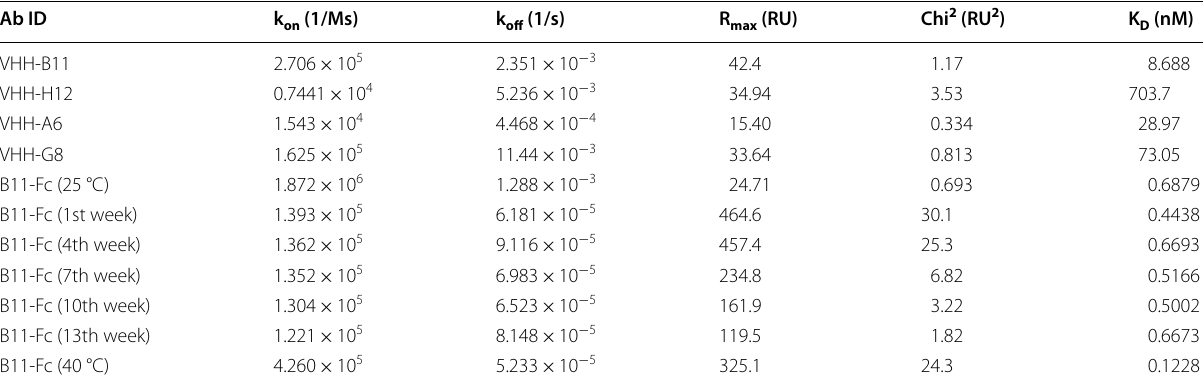
Ab ID represents the name of each antibody. k on (1/Ms) and k off (1/s) values, respectively represent the binding and dissociation levels of the VHH interacted with the hPCSK9. K D (M) was the measured affinity value acquired by the k off value divided by the k on value. R max (RU) represents the maximum binding response unit. Chi 2 (RU 2 ) represents the curve-fitting accuracy, generally 1/10 R max (RU). 25 °C/40 °C represents the reaction temperatures of the affinity determination assay by SPR. ≤ B11-Fc (xx week) represents their affinities which were detected at the preservation end of the 1st, 4th, 7th, 10th, and 13th